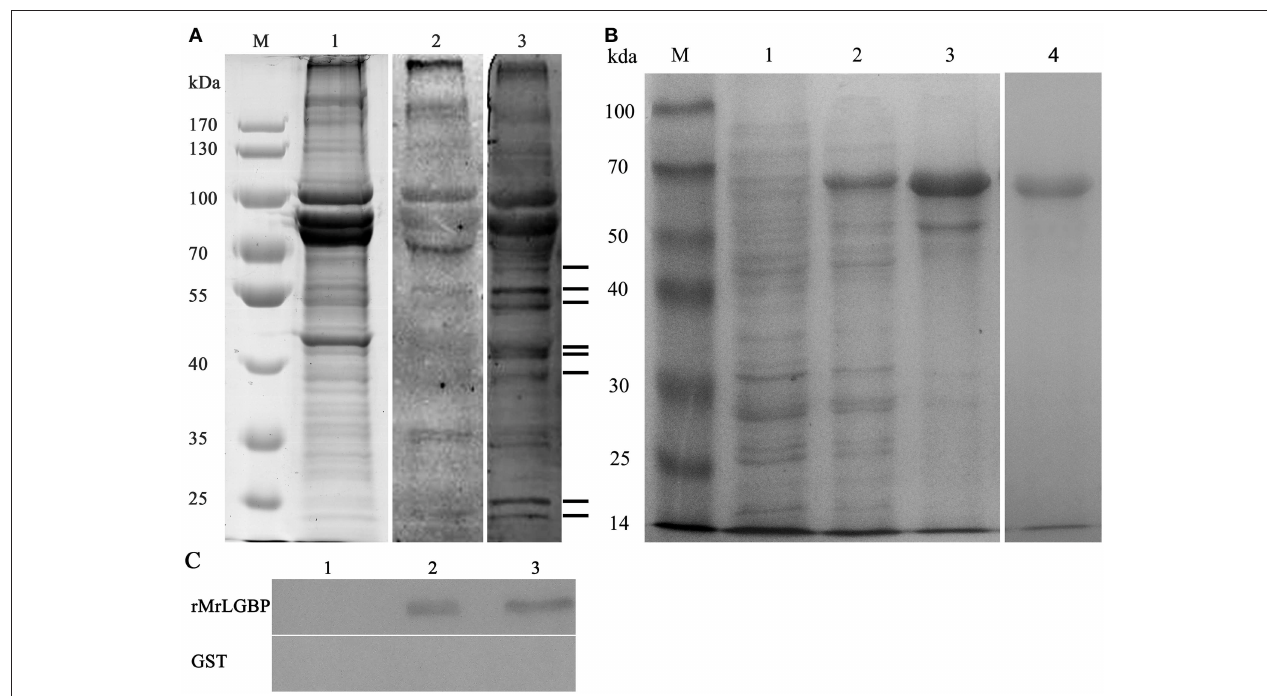
FIGURE 1 | The identified receptor proteins from interactions between M. rosenbergii hemocytes and S. eriocheiris . (A) The far western blotting analysis to identify proteins on hemocytes that could bind to S. eriocheiris . M. rosenbergii hemocytes total proteins were analyzed by SDS-PAGE (Lane M and 1). Hemocyte receptor proteins were detected by far western blotting (Lane 2 and 3). Lane M, molecular weight marker. Lane 1, M. rosenbergii hemocyte proteins (20 µ g). Lane 2, control blot not probed with S. eriocheiris bacteria. Lane 3, experimental blot probed with S. eriocheiris bacteria. Black lines on the right indicate the eight significant binding